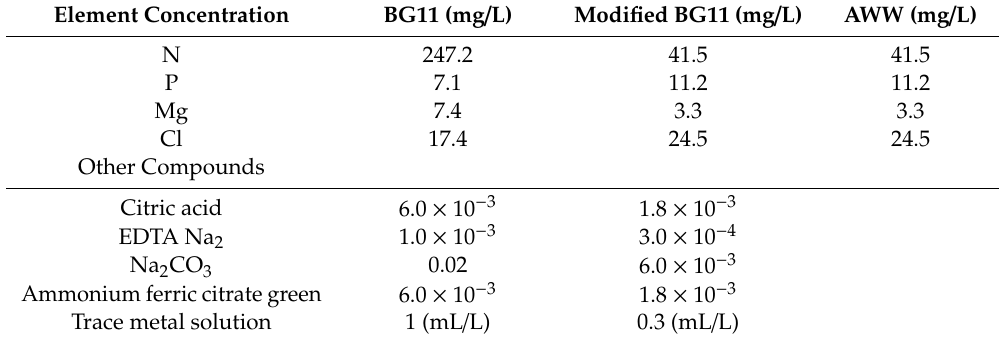
Table 2. Concentrations of chemicals in the modified BG11 growth